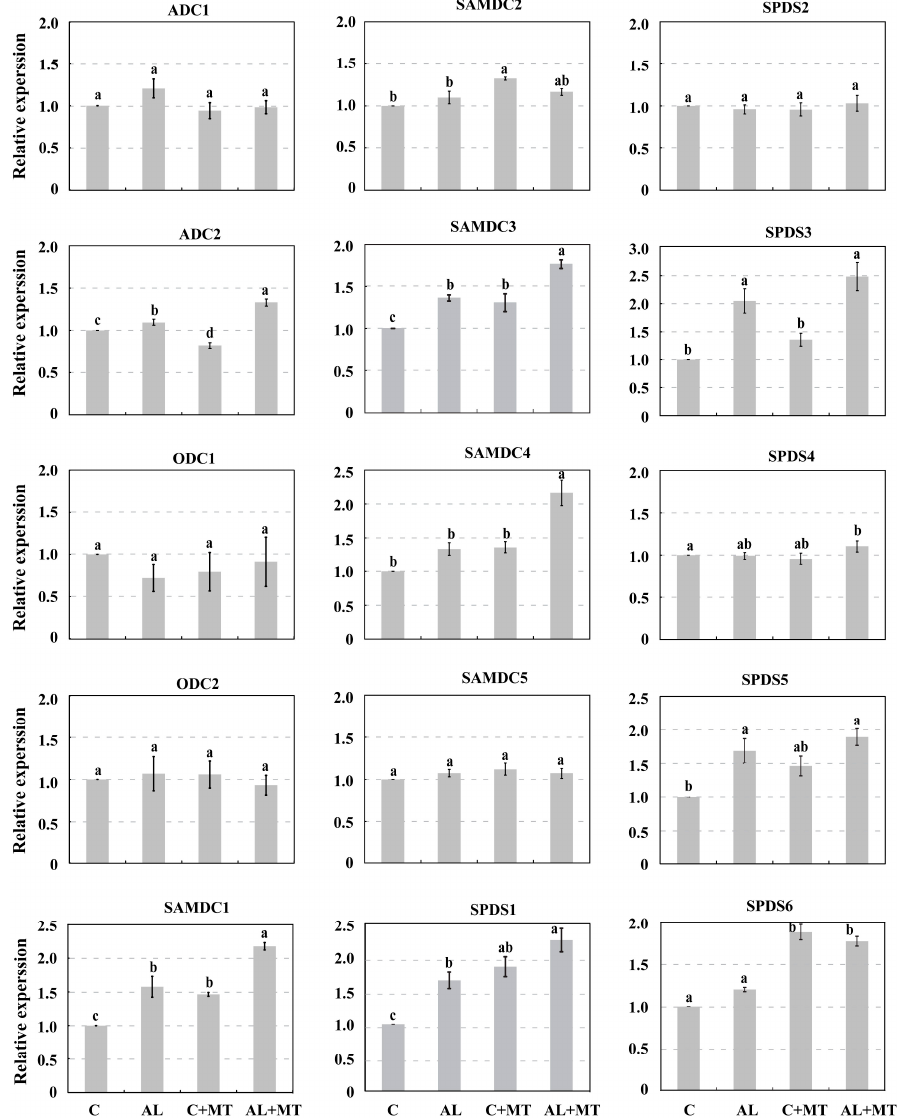
Figure 8. Expression of genes involved in biosynthesis of polyamines in Malus hupehensis Rehd. seedlings in response to alkaline stress and/or melatonin treatment. Expression levels were calculated relative to expression of MDH . All data are means ± SD of four replicates, and lower-case a and b indicate significant differences among treatments, based on Duncan’s multiple range test ( p < 0.05).